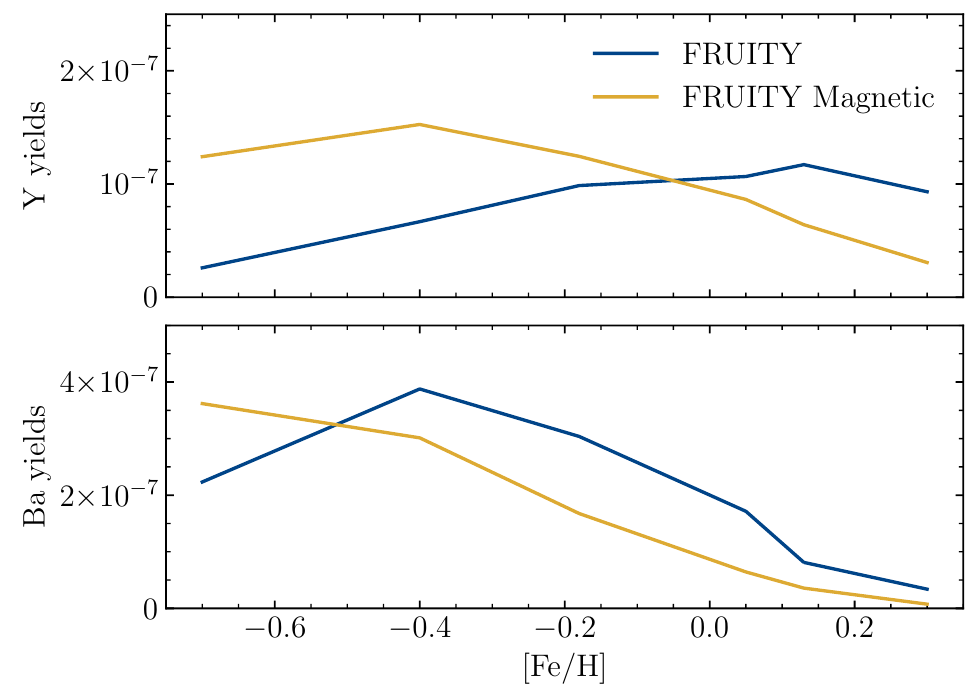
Figure 4. Net yttrium (top panel) and net barium (bottom panel) yields as a function of [Fe/H] for a 2 M AGB star as predicted by FRUITY and FRUITY Magnetic (cid:12)